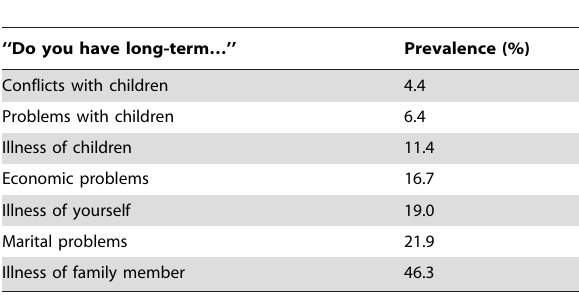
Table 2. The seven items in construct of stress in order of increasing